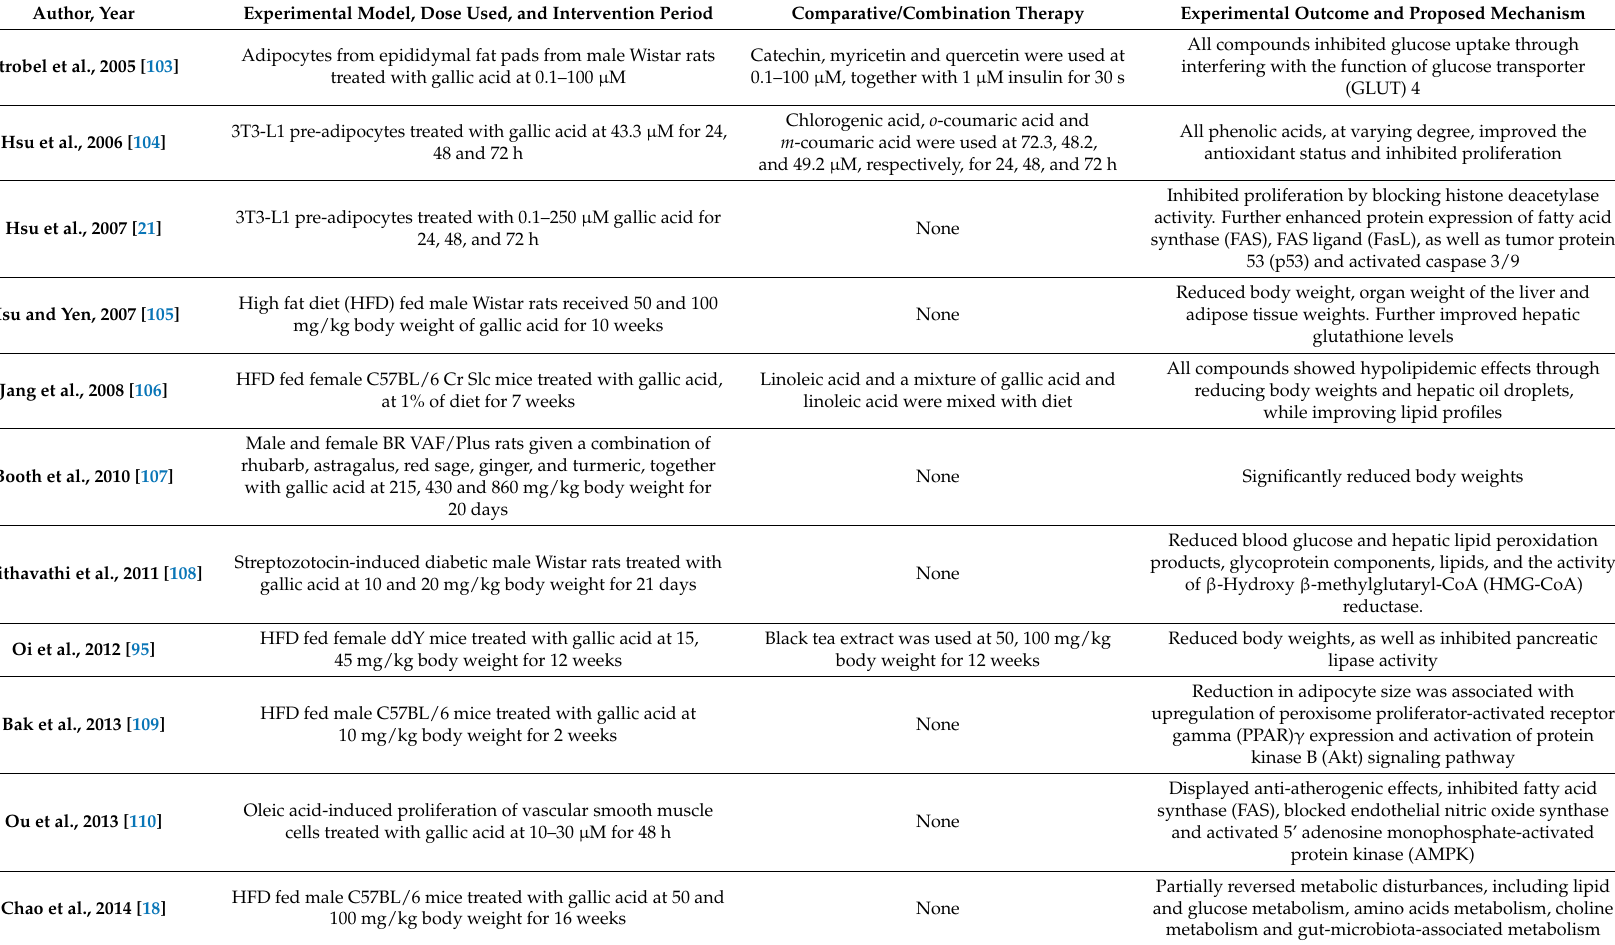
Table 1. Overview of studies reporting on the ameliorative effect of gallic acid against obesity-associated